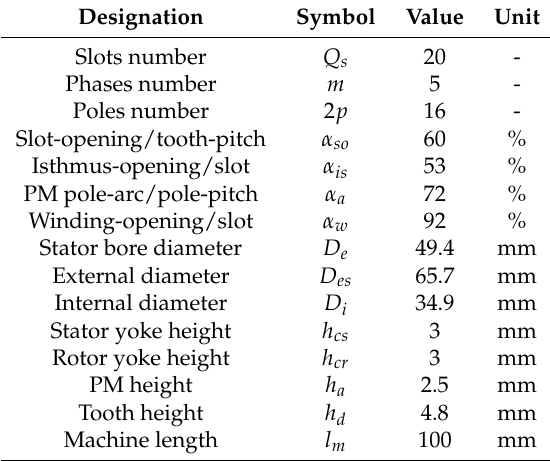
Table 1. Geometrical data of the machine